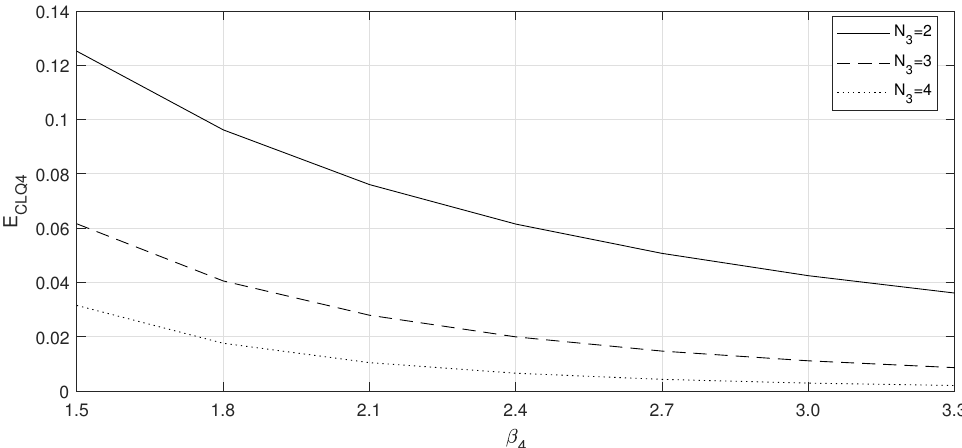
Figure 9. Expected customer loss in Queue-4 on α 4 vs. N 3 .